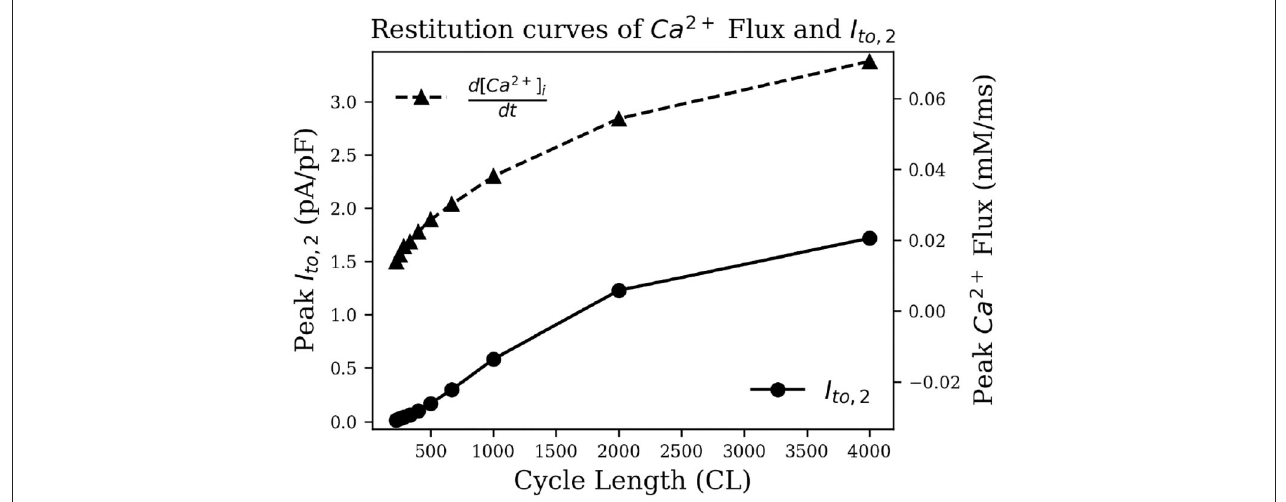
FIGURE 8 | Restitution curve of peak intracellular calcium flux (dashed) and peak I ClCa (solid).